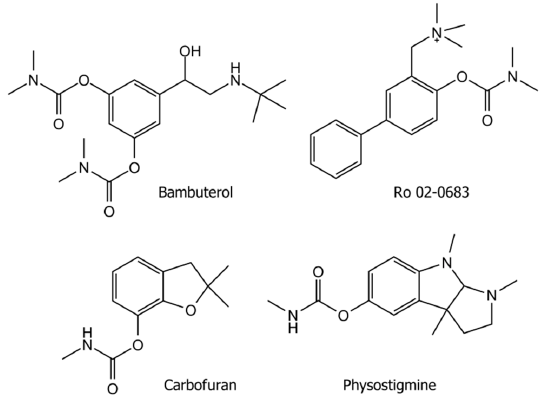
Figure 1. Structures of selected